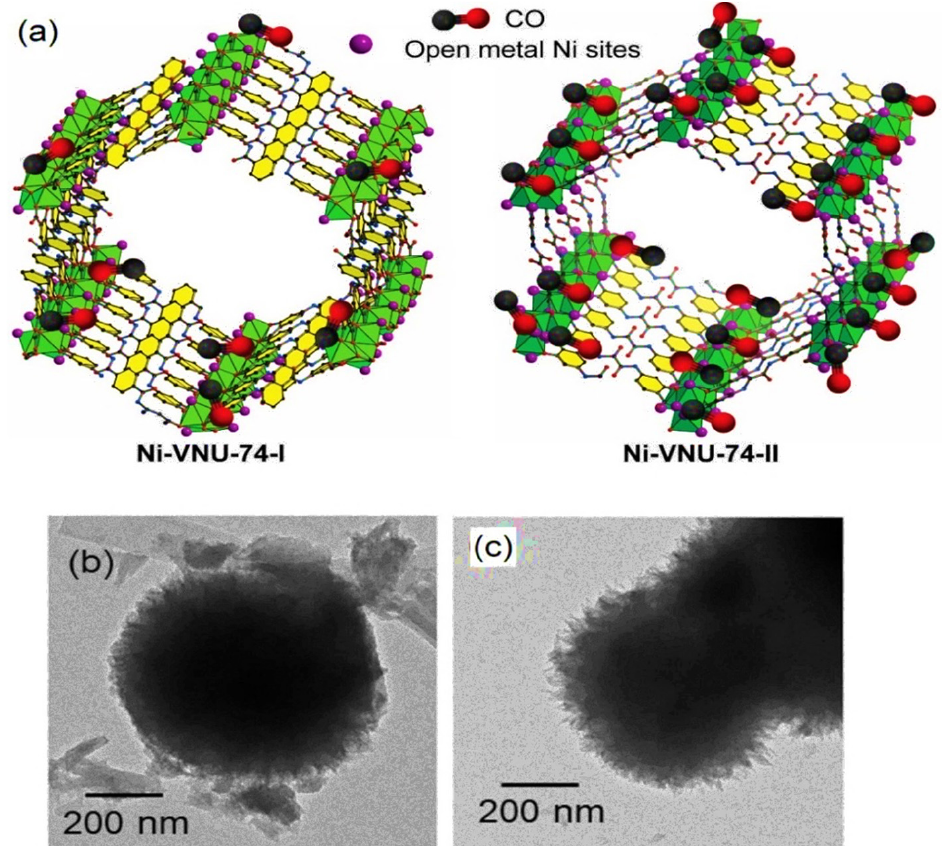
Figure 38. ( a ) Structures of Ni-VNU-74-I and–II. TEM images of ( b ) Ni-VNU-74-I and ( c ) Ni-VNU- 74-II. Reproduced from [135] with the permission of Elsevier. II. Reproduced from [135] with the permission of